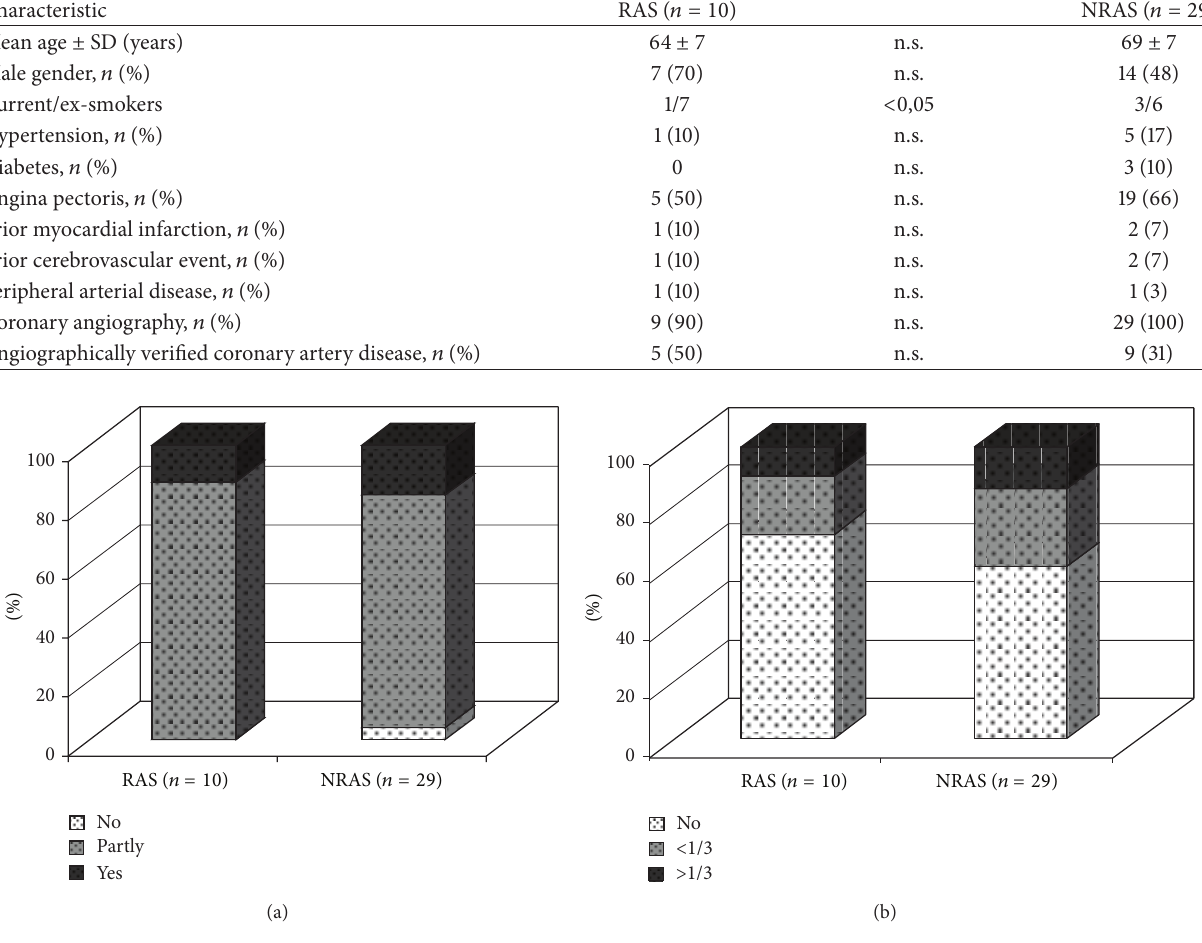
Figure 1: (a) Destruction of architecture in RAS as compared to NRAS; data given as percent (%) of ( 𝑛 ). (b) Degree of neovascularisation in RAS as compared to NRAS, < 1/3 = in the basal third of valve cusp, > 1/3 = beyond basal third of valve cusp; data given as percent (%) of ( 𝑛 ). RAS = rheumatic aortic stenosis, NRAS = nonrheumatic aortic